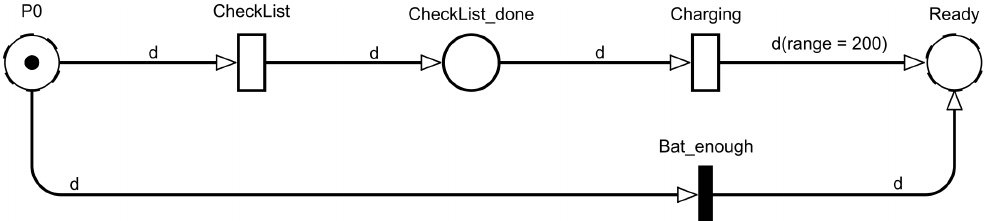
Figure 4. The preflight procedures execution model “ Preparation